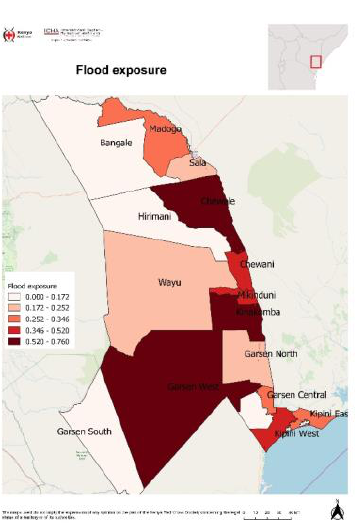
Figure 7 2016-04-05 Sentinel 1 flood extent